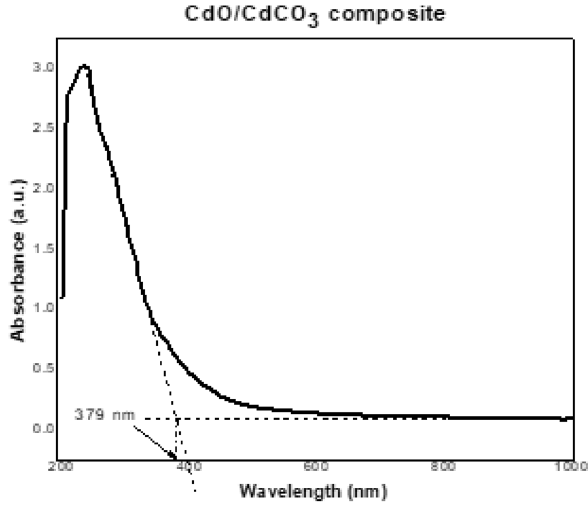
Figure 7. CdO/CdCO 3 composite NPs UV–Vis spectra showing absorption edge at 379 nm.